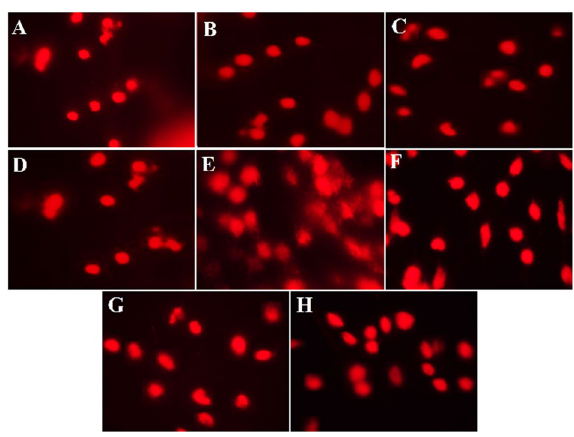
Figure 5. Comet assay showing the percentage of DNA damage in rats subjected to different treatments in CDDP-induced nephrotoxicity. ( A ) the control group showed a small percentage of DNA damage (2%—5%). ( B ) the GA group showed (6–15%) DNA damage. ( C ) the CMCS group showed (7–13%) DNA damage. ( D ) the GA@CMCS group showed (5–11%) DNA damage. ( E ) high DNA damage (70–80%) was observed in the CDDP group compared with the control group. ( F ) the (CDDP + GA) group revealed reduced DNA damage compared with the CDDP group (30–40%). ( G ) the (CDDP + CMCS) group revealed reduced DNA damage compared with the CDDP group (20–30%). ( H ) the (CDDP + GA@CMCS) group revealed reduced DNA damage compared with the CDDP group (27–30%).